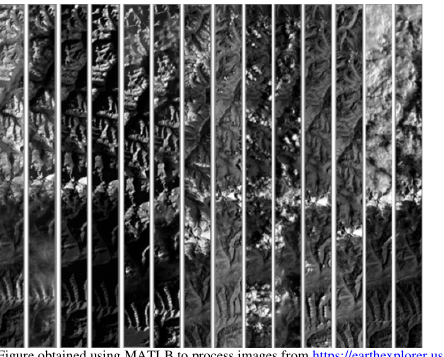
Figure obtained using MATLB to process images from https://earthexplorer.usgs.gov/ Figure 4. Fourteen Hyperion images selected for the